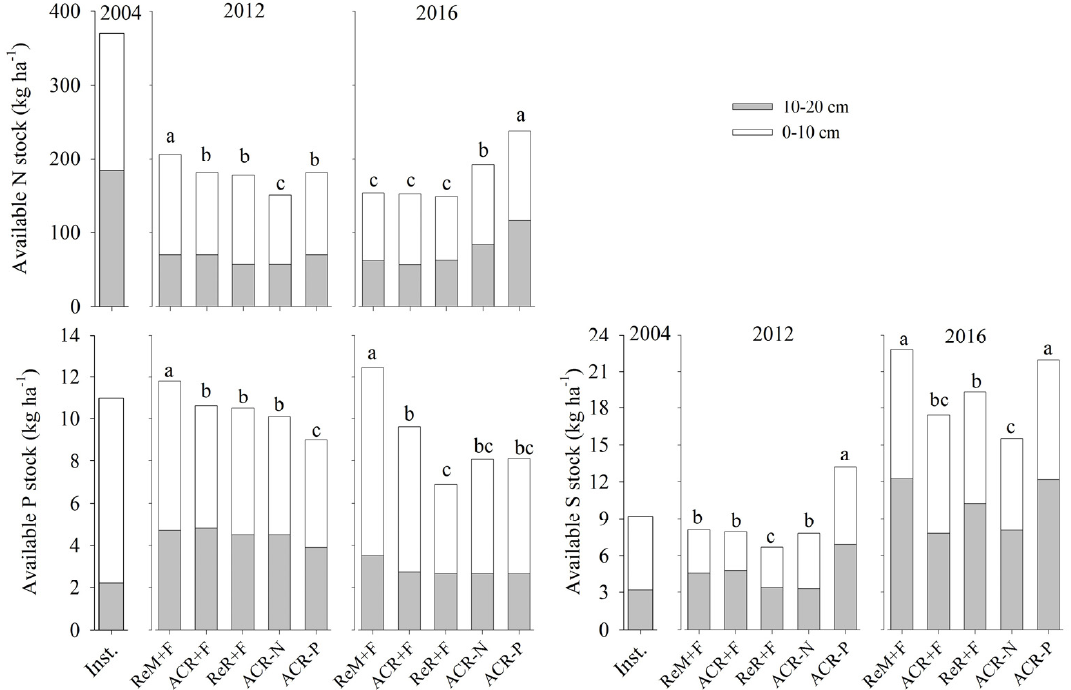
Figure 1. Available N, P, and S stocks in the 0–20 cm soil layer before the setup of treatments (2004), before the harvest of the first rotation (2012), and at four years into the second rotation (2016) in a Eucalyptus plantation under different harvest residue management and fertilizer application strategies. P was determined by resin extraction, S was determined by extraction with Ca(H 2 PO 4 ) 2 0.001 mol · L − 1 , and available N was calculated assuming that 10% of total N is mineralizable [28]. Columns with the same letter are not significantly different from each other.